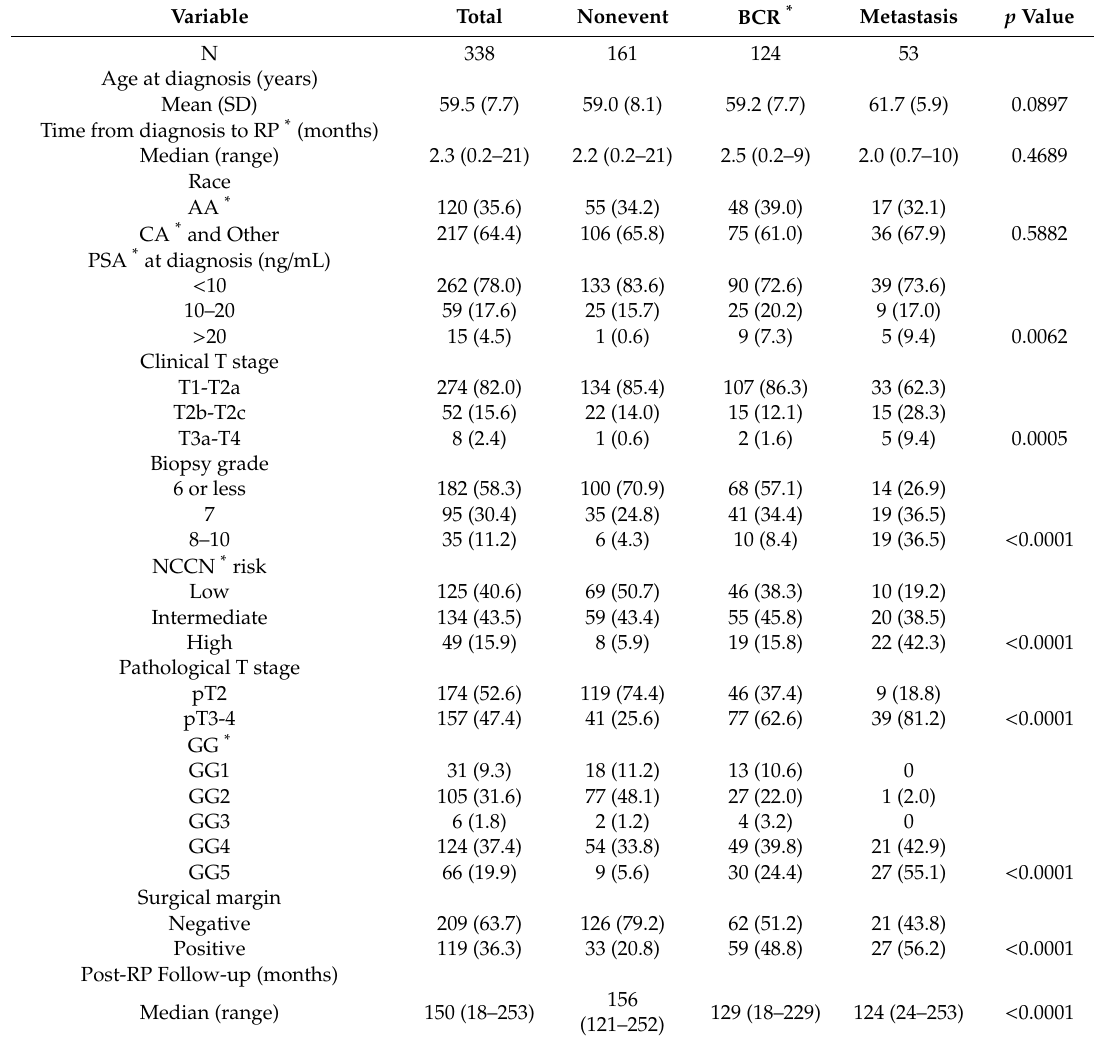
Table 1. Descriptive characteristics of study cohort stratified by event status (n =